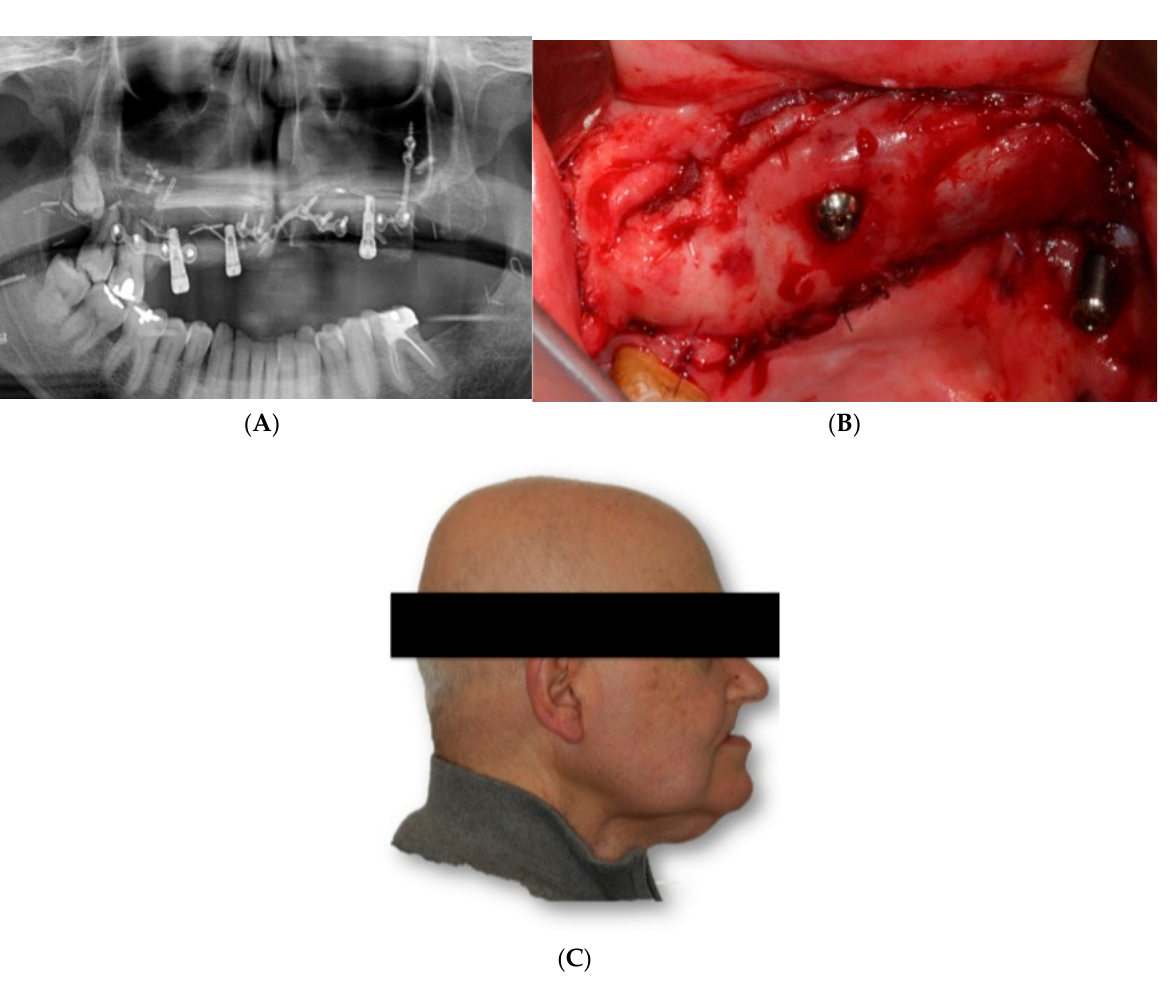
Figure 2. Bilateral fibula flap. ( A ) Ortopantomography showing both fibula flaps and the dental implants. ( B ) Intraoral view. ( C ) Clinical picture. Lack of maxillary projection.